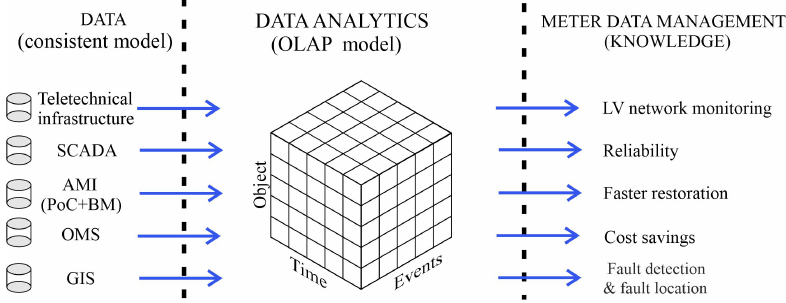
Figure 2. Model of data processing concerning the events recorded in the meters of the AMI system integrated with other systems (e.g., OMS, SCADA, GIS) in order to obtain knowledge about the condition of the power